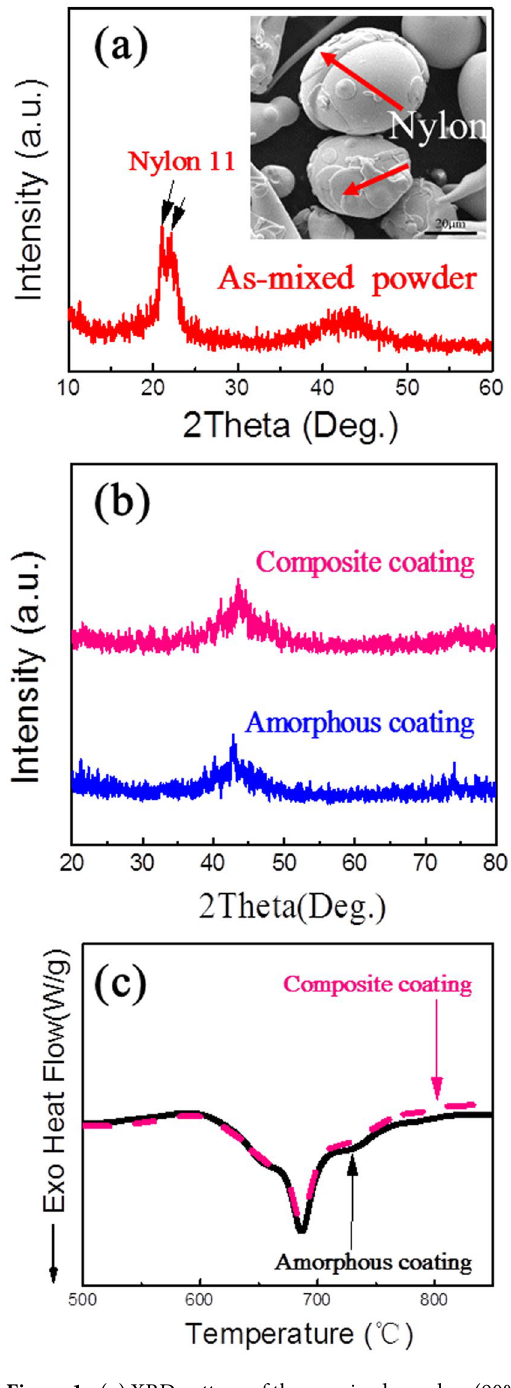
Figure 1. ( a ) XRD pattern of the as-mixed powders (90% amorphous powders and 10% nylon 11 powders). Inset shows the SEM morphology of the as-mixed powders. ( b ) XRD patterns and ( c ) DTA curves of monolithic amorphous coating and composite